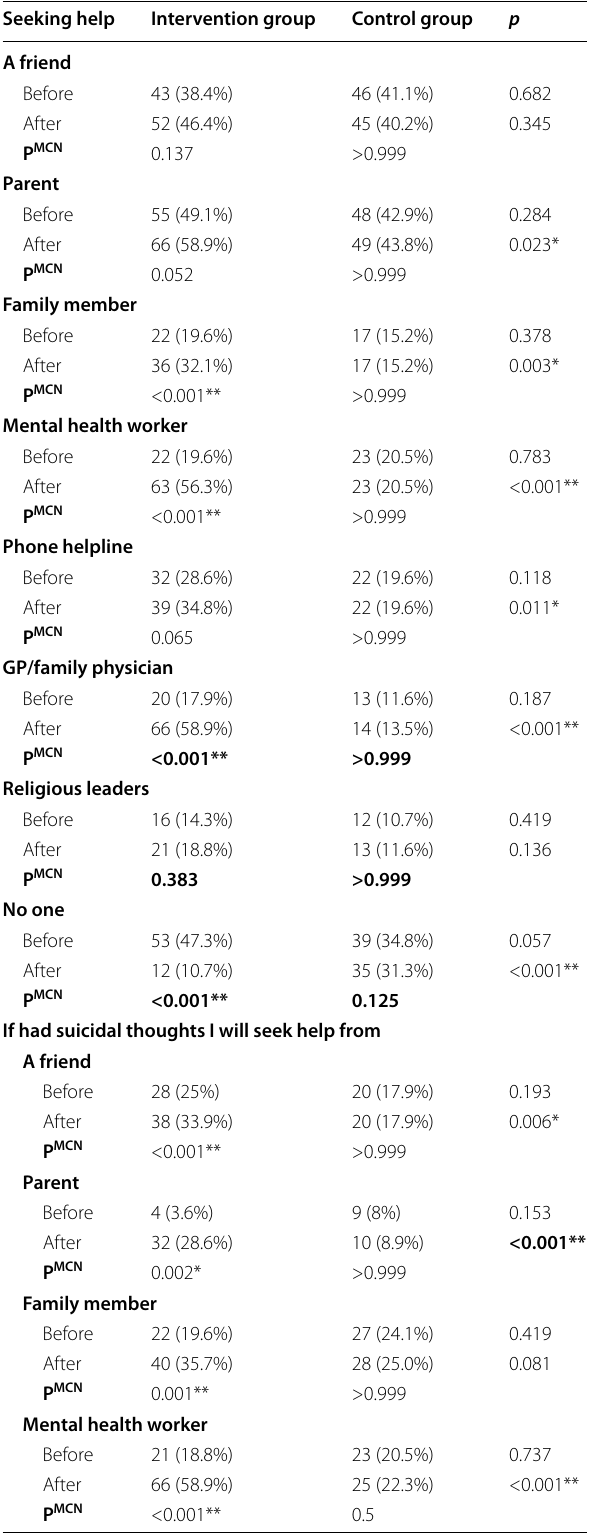
Table 5 Differences in help-seeking preferences between intervention and control groups